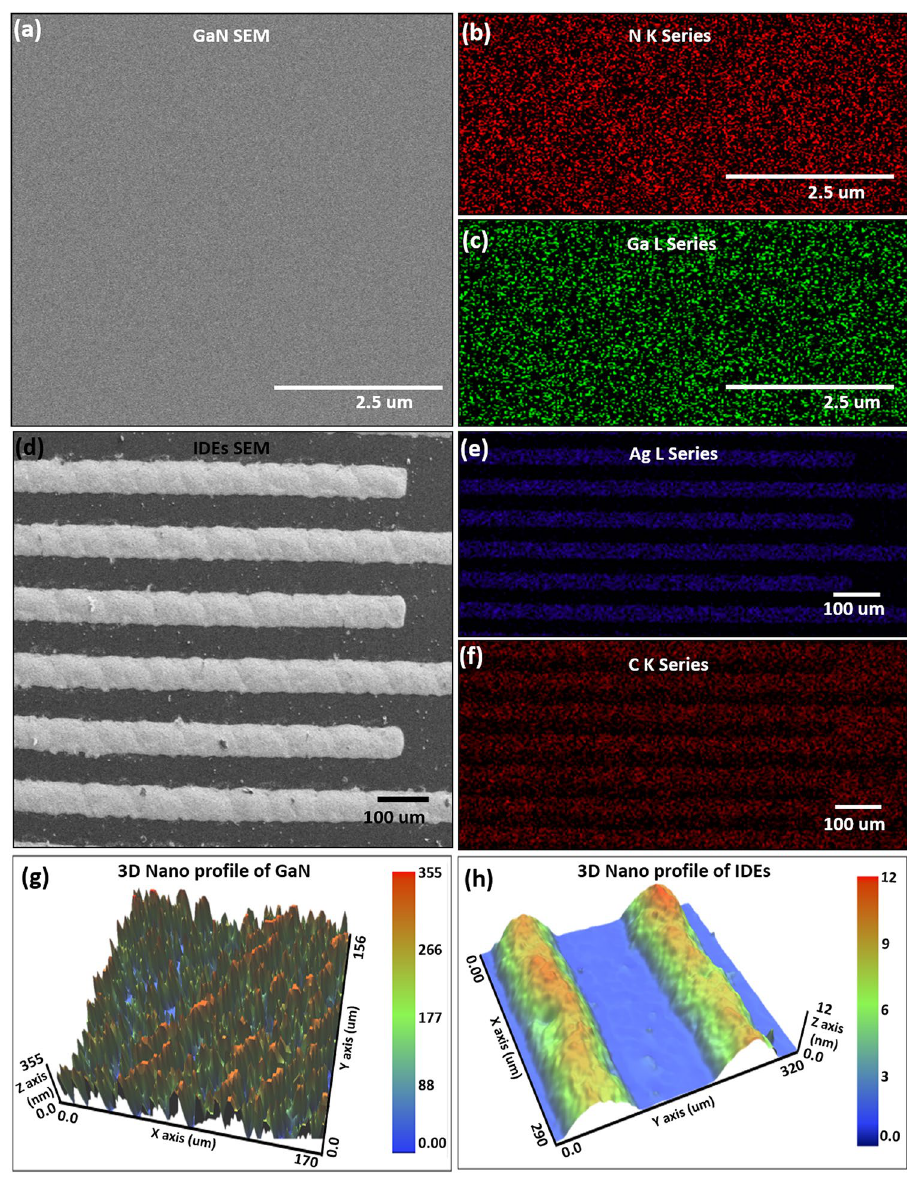
Figure 2. ( a ) STEM GaN layer, ( b ) nitrogen K series, ( c ) Ga L series, ( d ) STEM IDEs ( e ) silver L series, ( f ) carbon K series, nano-profile ( g ) GaN, and ( h )